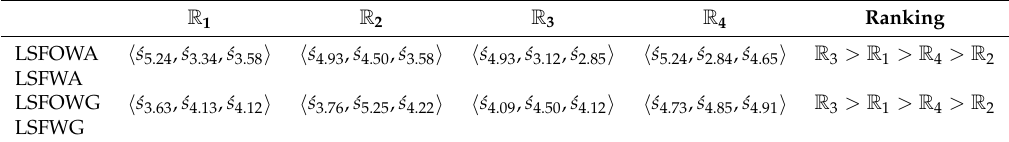
Table 6. Overall preference value and the alternatives ranking.